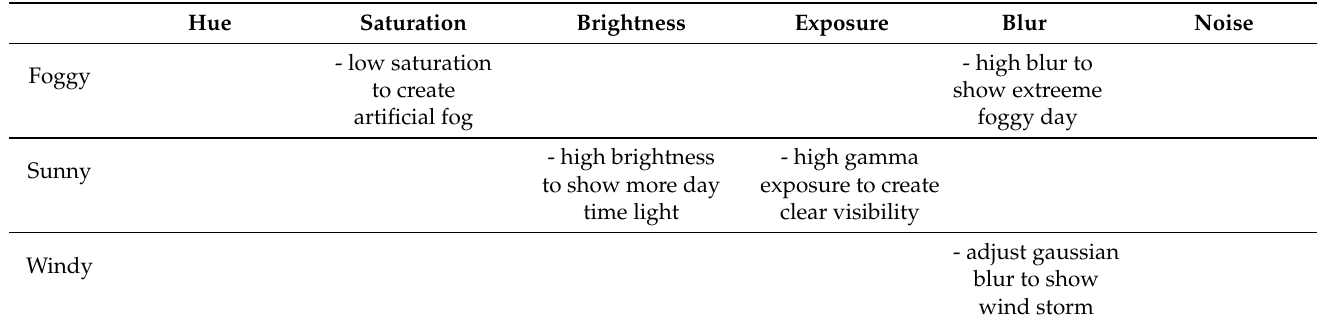
Table 1. Relation between augmentation techniques and weather